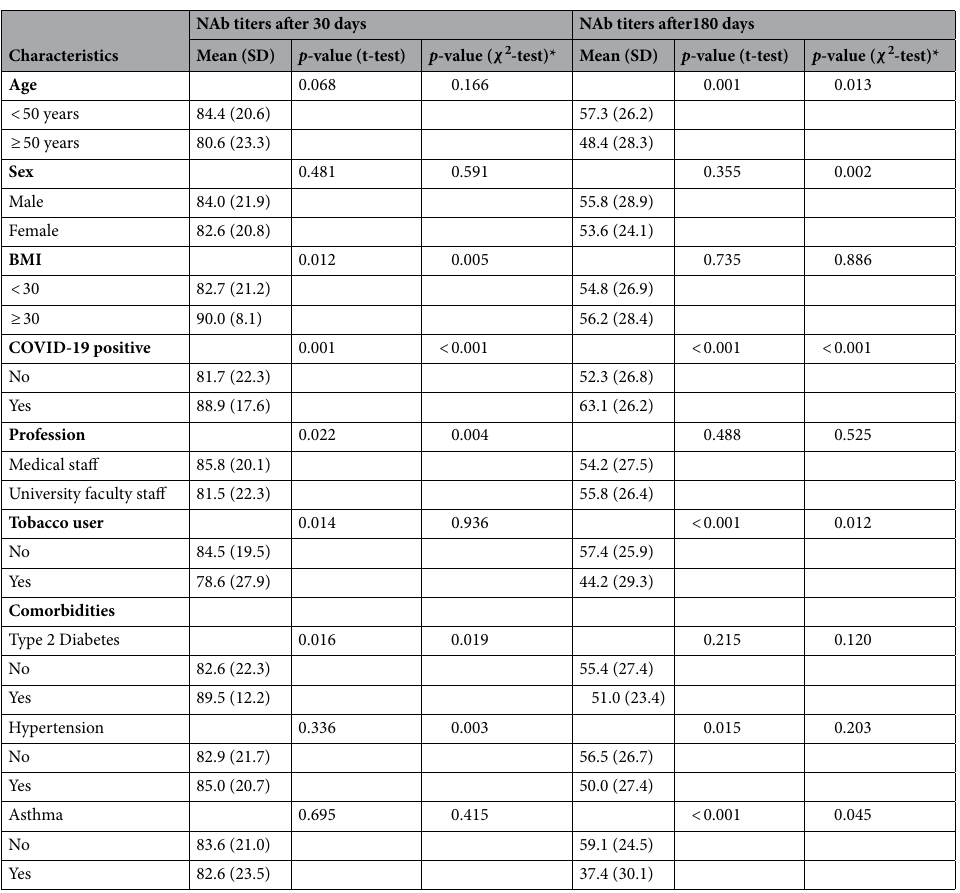
Table 2. Bivariate associations between demographic and health-related variables, and NAb titers after 30 and 180 days of vaccination. SD standard deviation, Nab neutralizing antibody. * p -values for chi-square test were calculated from the differentials in Nab titer categories (< 70, 70–95, ≥ 96) by different socio demographics and health-related variables included in Table 2.